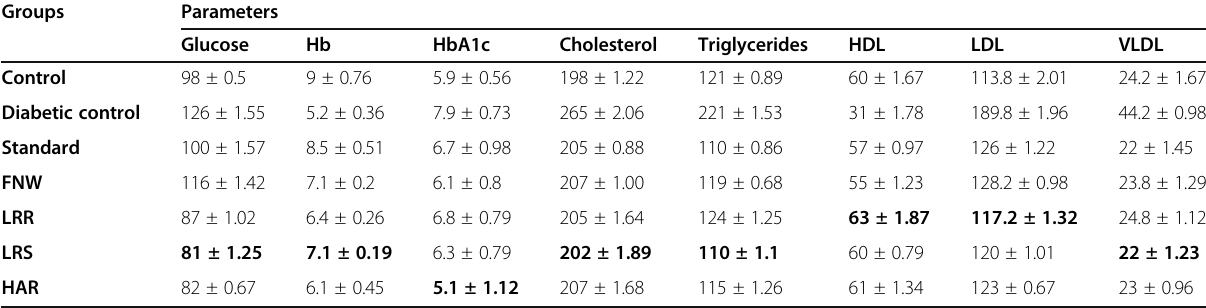
Table 6 Anti-diabetic activity in STZ-induced diabetic rats Groups